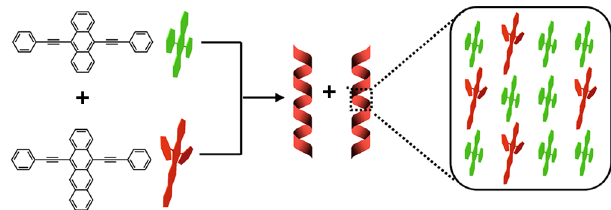
Fig. 4 Schematic illustration of the molecular packing of (BA) 0.72 (BN) 0.28 alloy helices. In (BA) 0.72 (BN) 0.28 alloy helices, the BA host molecules